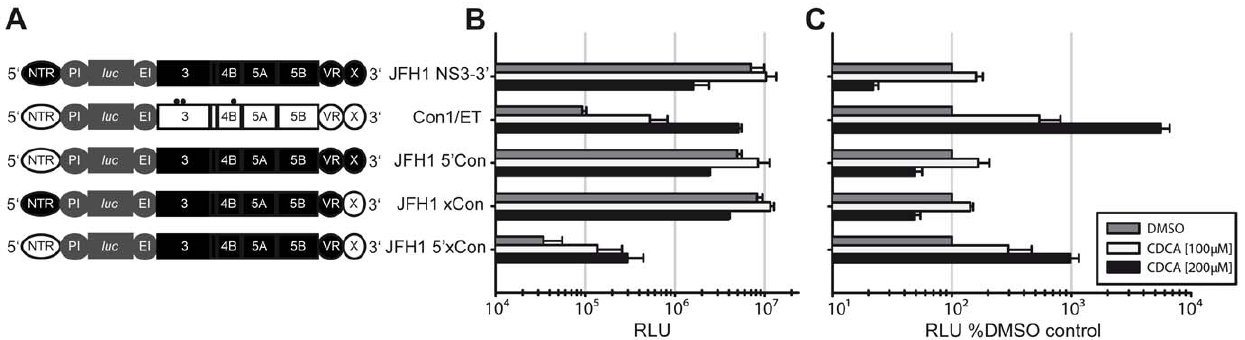
Figure 4. Viral determinants required for BA- mediated stimulation. A: Schematic representation of JFH1 NS3-3 9 , Con1/ET JFH1/Con1 intergenotypic chimeras. Replication enhancing mutations of Con1/ET are marked as black dots. All viral proteins were JFH1-derived and either the 5 9 NTR or the terminal end of the 3 9 NTR (X-tail) or both were exchanged by those of Con1. B: Lunet G-luc cells were transfected and seeded on a 12- well plate. Indicated bile acids were added after 4 h and luciferase activity was measured 72 h post-electroporation. C: Data were normalized to DMSO control.